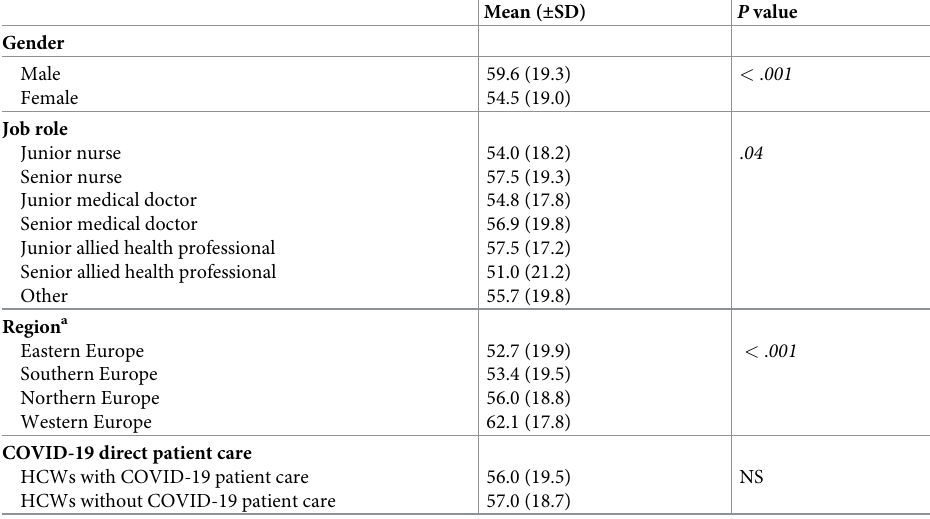
Table 2. WHO-5 emotional Well-Being Index per subgroup.